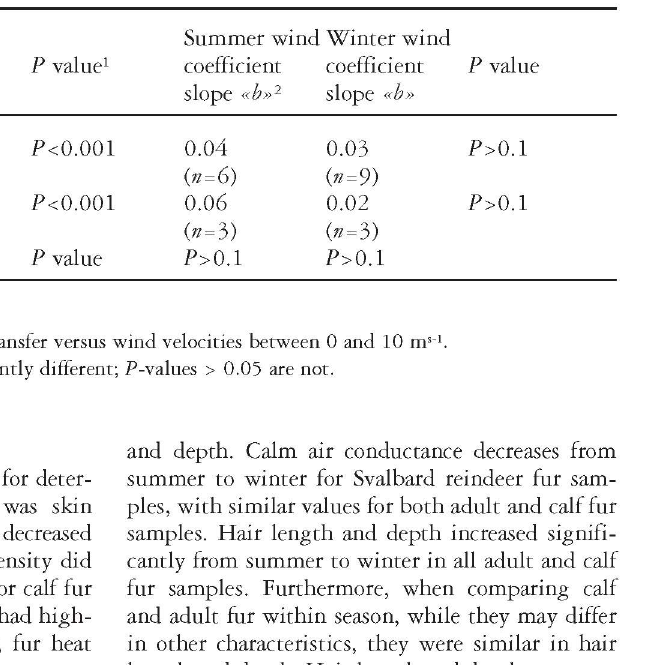
Table 6. Svalbard adult/calf fur samples and heat transfer: seasonal calm air conductance (C) and response to increasing wind velocity (from Cuyler & Øritsland, 2002). Fur Summer